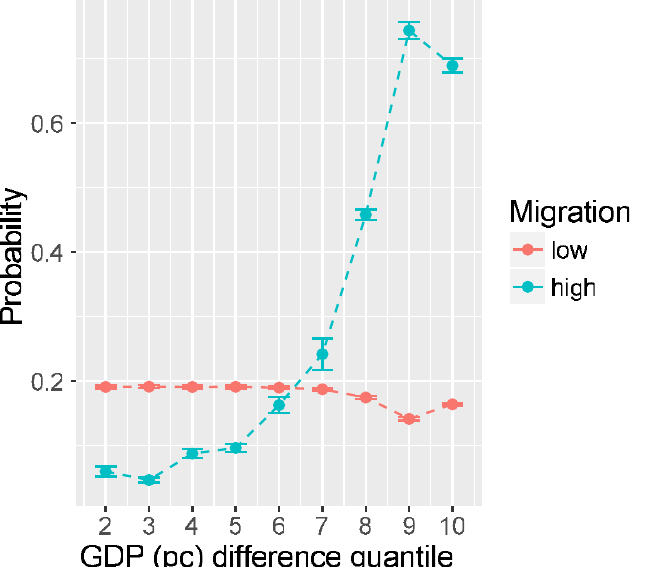
Fig 5. Marginal effects of GDP per capita difference and level of migration. Y-axis measures the probability of observing large numbers of transactions (i.e., the outcome Q ijfy falling into a “high” category), as a function of GDP difference quantile and for different levels of migration (low vs. high). For low migration the probability shows no increase with GDP difference quantile, but for high migration the probability shows a significant increase–specifically beyond the 50th percentile of GDP difference. The plot shows that migration is only effective when it moves migrants from a low GDP to a high GDP country (which corresponds to direction across a large and positive GDP difference).